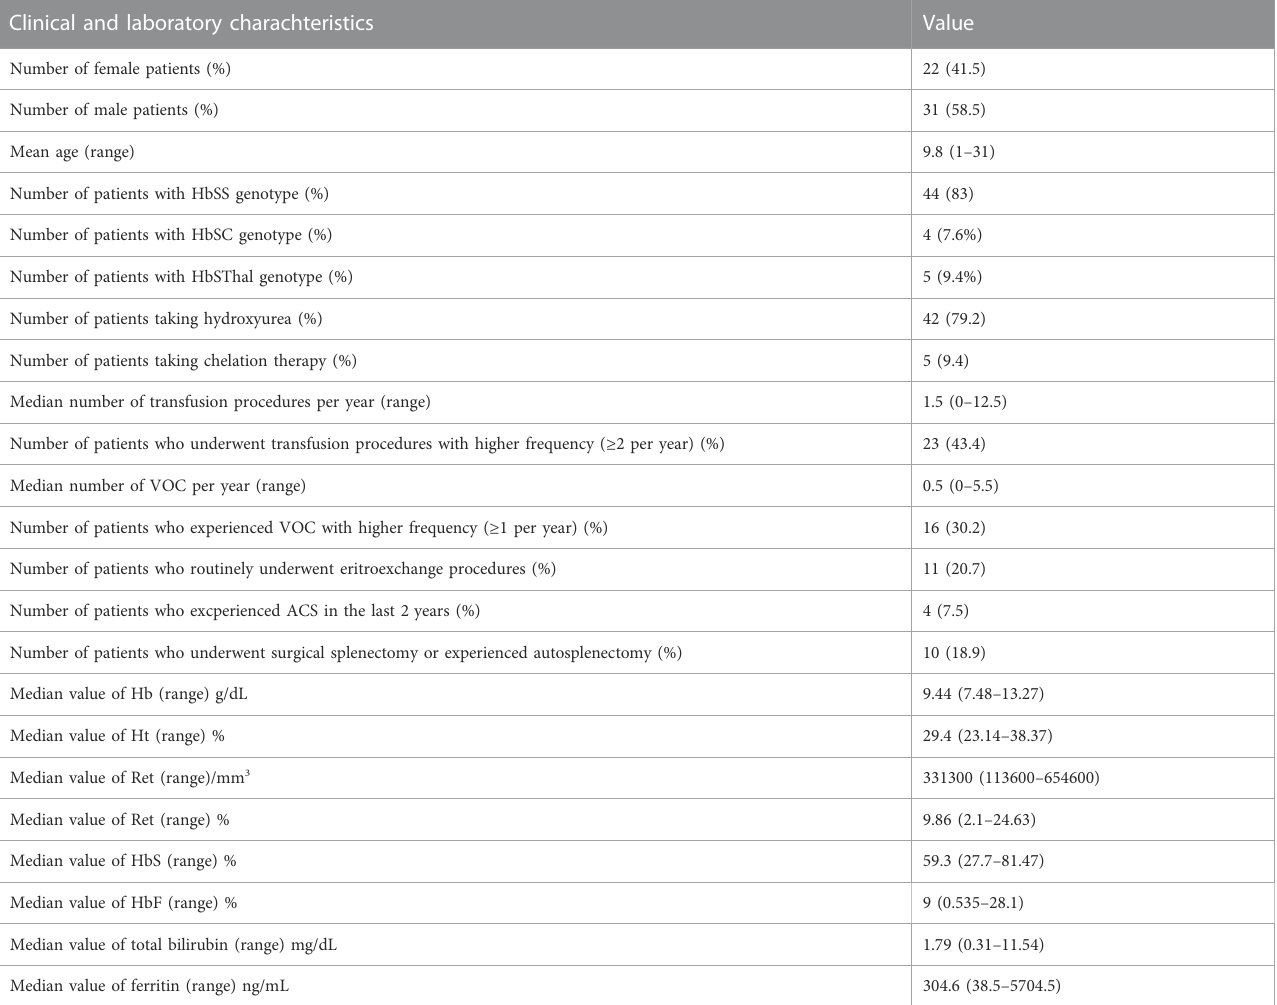
TABLE 2 Clinical and laboratory characteristics of SCD population. Clinical and laboratory